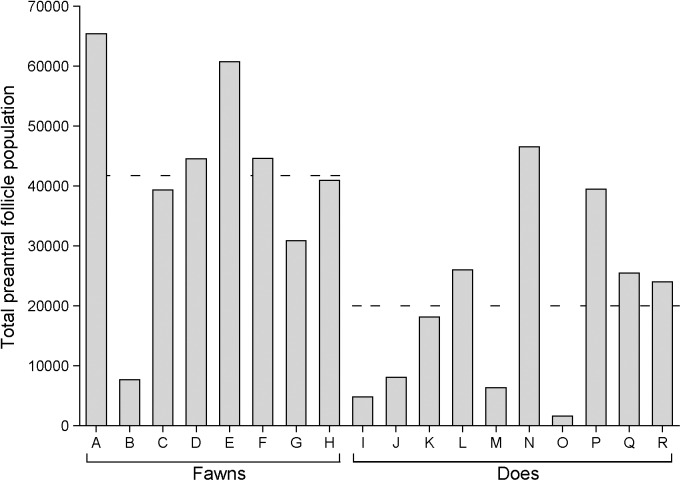
Preantral follicle population for each white-tailed deer fawns (n = 8) and does (n = 10).Dashed lines represent the mean for each age group.